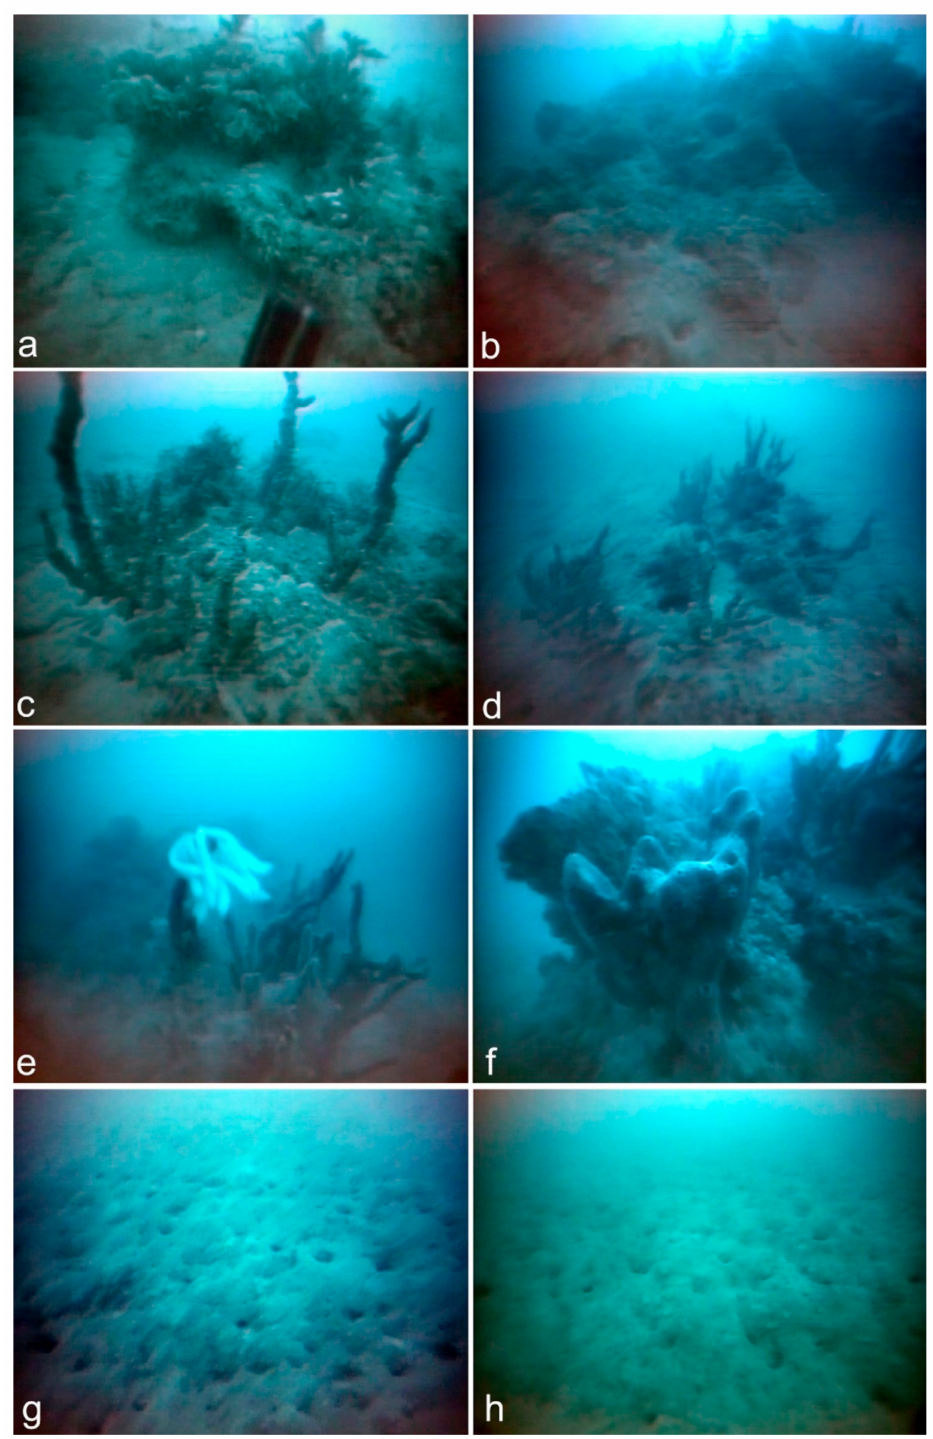
Figure 7. R.O.V. photos showing ( a , b ) coralligene algae reefs less than 1.0 m in height, ( c – e ) coralligene algae reefs covered by polychaetes and soft-tissue corals, ( f ) small sponges on the top of the coralligene reef and ( g , h ) an abundance of depressions (a few cm in scale) on a monotonous soft sandy